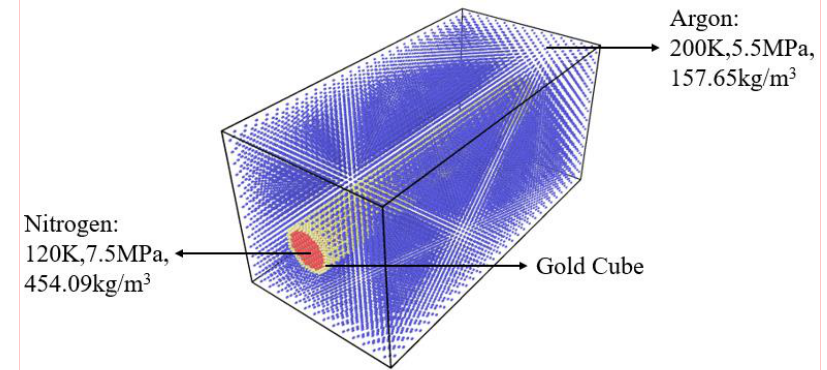
Figure 2. Closed binary system simulation box, size L x × L y × L z ( L x = 200 Å , L y = 800 Å , L z = 20Å ). A gold tube sits in the middle of the left surface, filled with subcritical nitrogen (120 K, 7.5 MPa, 454.09 kg/m 3 ) and surrounded by supercritical argon (200 K, 5.5 MPa, 157.65 kg/m 3 ).